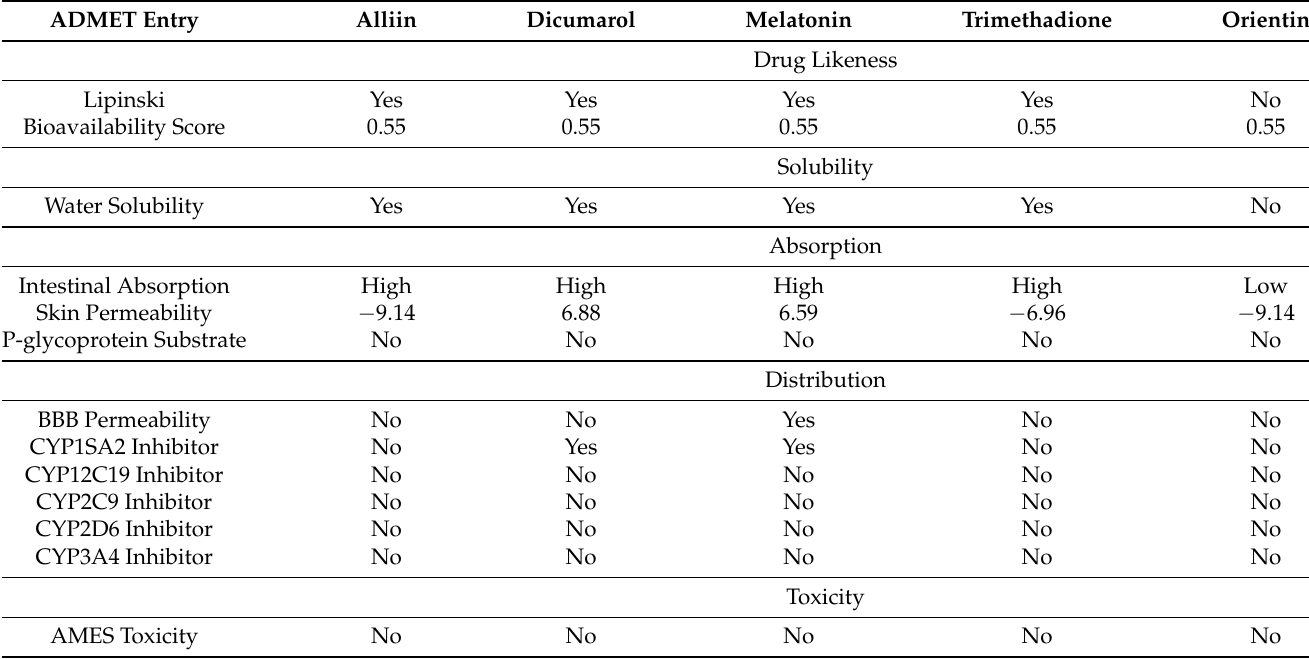
Table 4. ADMET identified properties of top three phytobioactives together with Dicumarol and Melatonin. ADMET Entry Alliin Dicumarol Melatonin